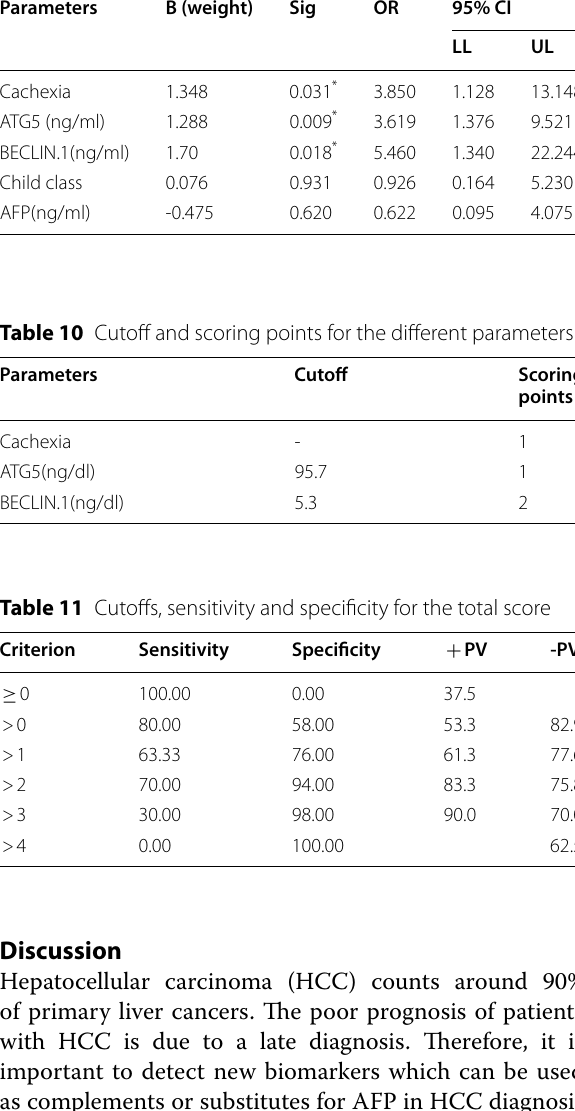
Table 9 Multivariate analysis logistic regression for predict HCC Parameters